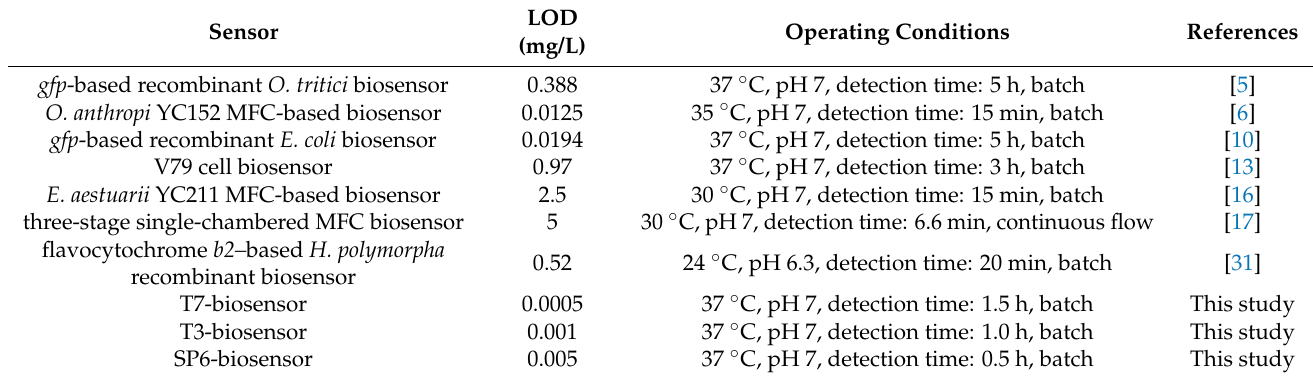
Table 2. LOD values and operating conditions of different biosensor for Cr(VI)